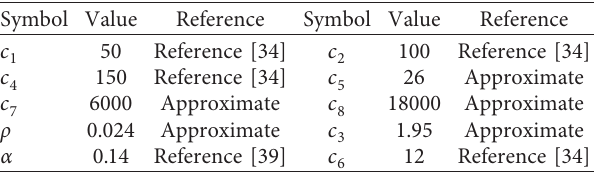
Table 2: Parameter values.